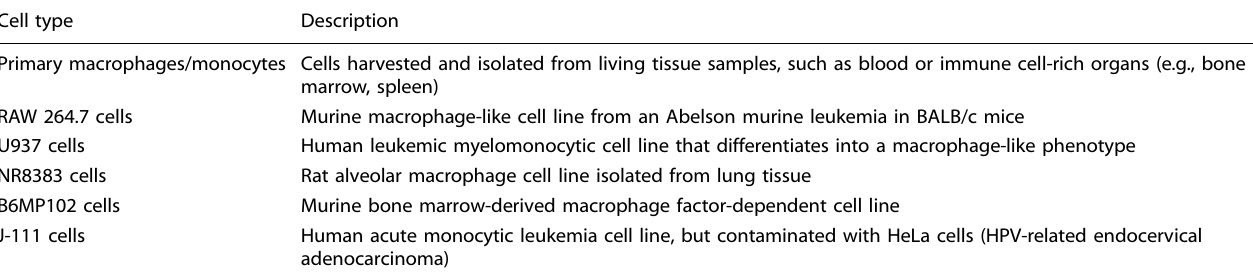
Table 1. Summary of major macrophage cell sources used in microgravity